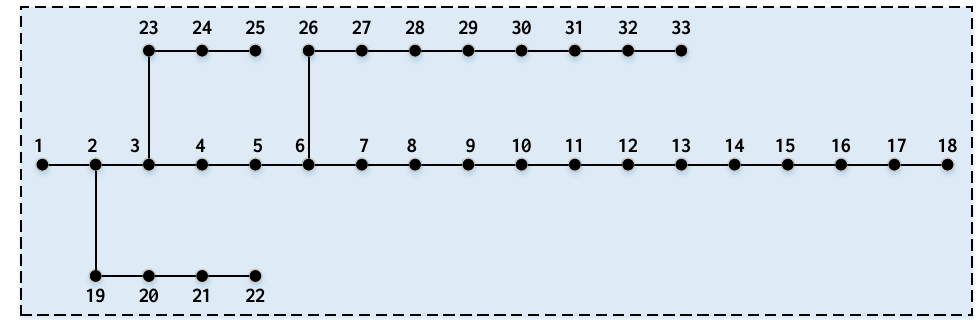
Figure 5. Typical IEEE-33 bus system.